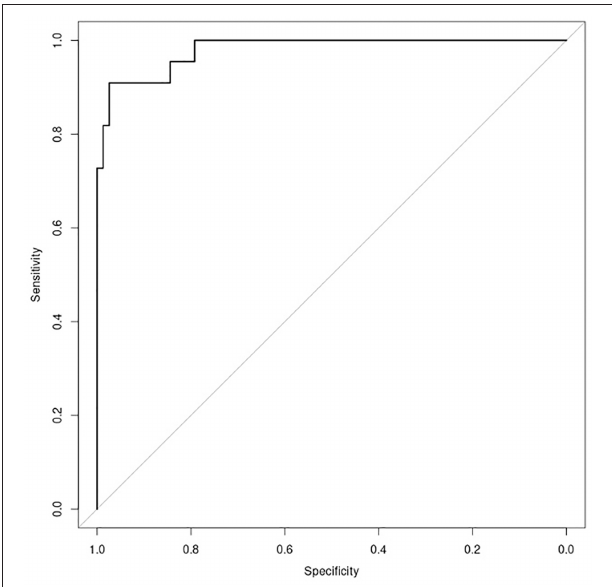
FIGURE 2 | Plot of ROC curve for the “anesthesia” model (AUC = 0.9875), showing possibility to identify patients who need anesthesia support with regards to the total score, achieved putting into the model the value of relevant items of